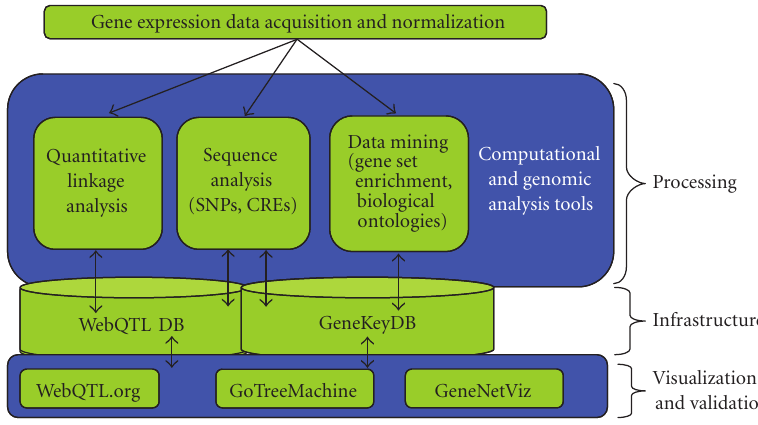
Figure 1. A process